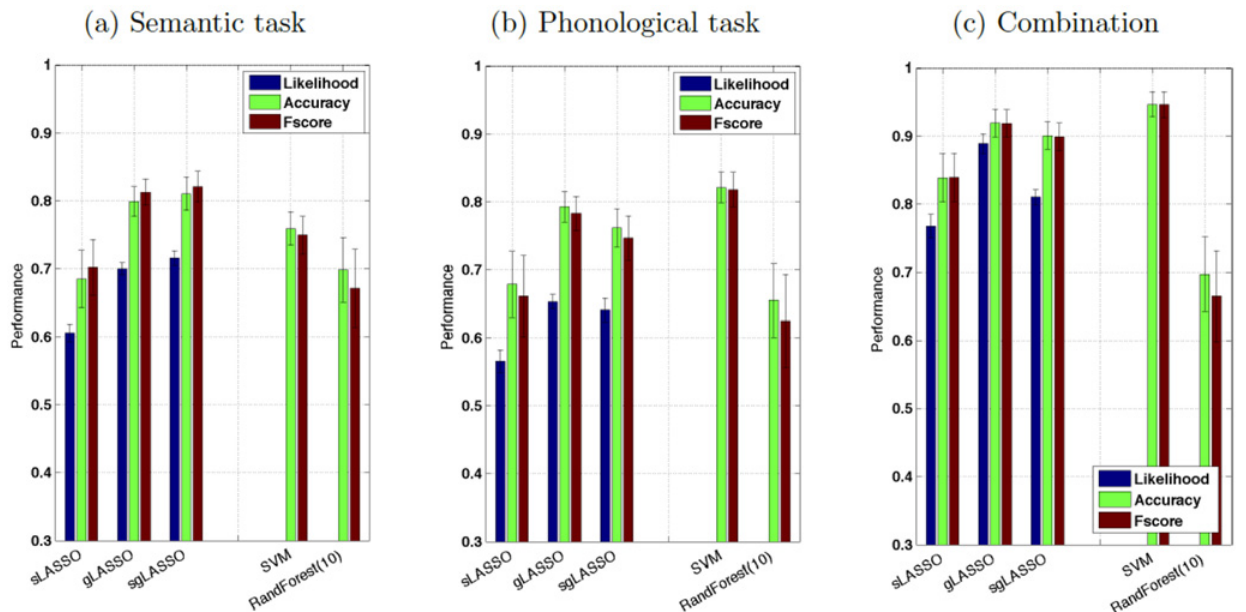
Fig 5. Relative performance of gLASSO, sgLASSO and SVM, depended on the dataset, while sLASSO and Random Forest were generally outperformed by the other algorithms. (a) semantic verbal fluency, (b) phonological verbal fluency and (c) combined datasets. Classification performance was significantly different between all algorithms and significantly higher for each algorithm with the combined dataset ( p < 0.001, u-test).